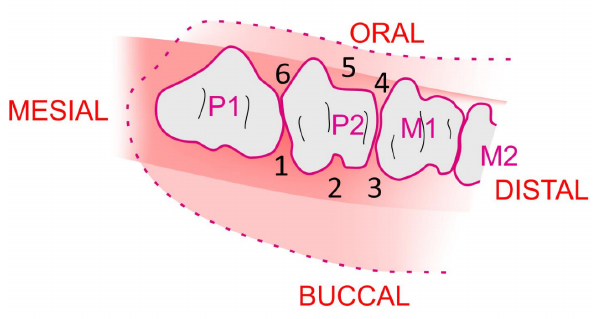
Fig. 2. Measurement of primary observed parameters, probing pocket depth (PPD) and clinical attachment level (CAL). PPD and CAL were measured at six locations around the sec- ond mandibular premolar before treatment (day 0) and on the day of necropsy (2 weeks, 6 weeks or 12 weeks